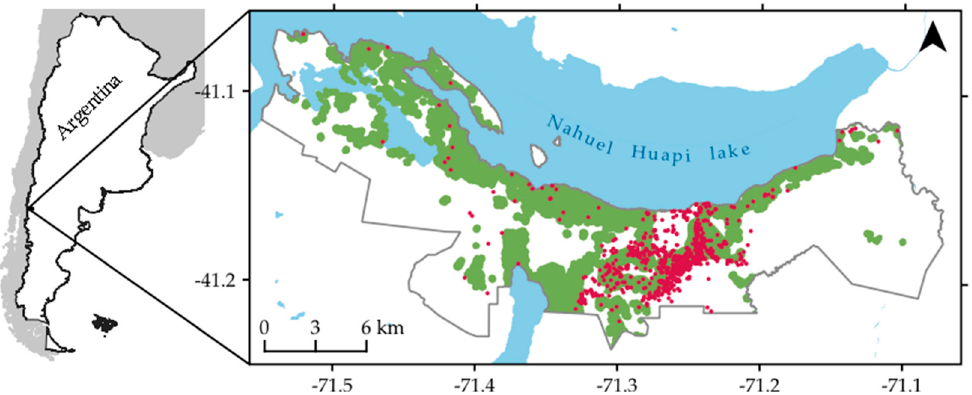
Figure 1. Wildland-urban interface (green) of Bariloche district (grey line polygon), located in north-western Patagonia, Argentina. Fire ignition points from 2015–2021 are shown in red.